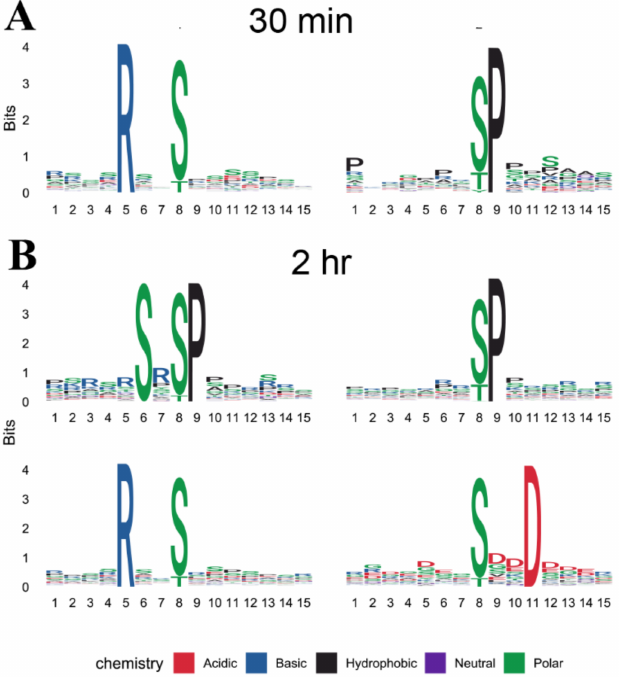
Figure 5. Motif analysis of cold up-regulated phosphopeptides. ( A ) Significantly enriched phospho- rylation motifs of maize B73 under 30 min of cold stress. ( B ) Significantly enriched phosphorylation motifs of maize B73 under 2 h of cold